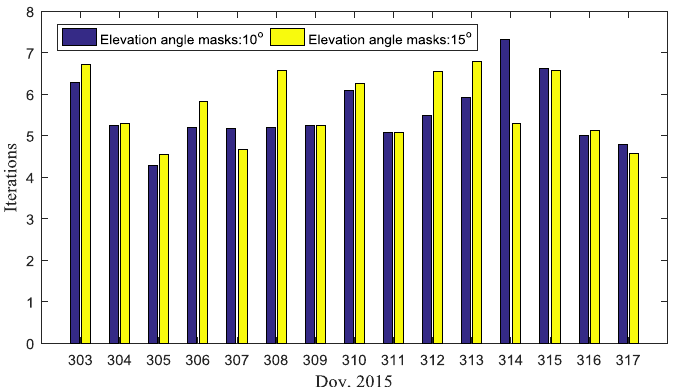
Figure 3. The statistics of Bartlett test and iterations under two conditions with elevation angle masks of 10° and 15°, respectively, over the experimental period of Doy 303 to 317, 2015.